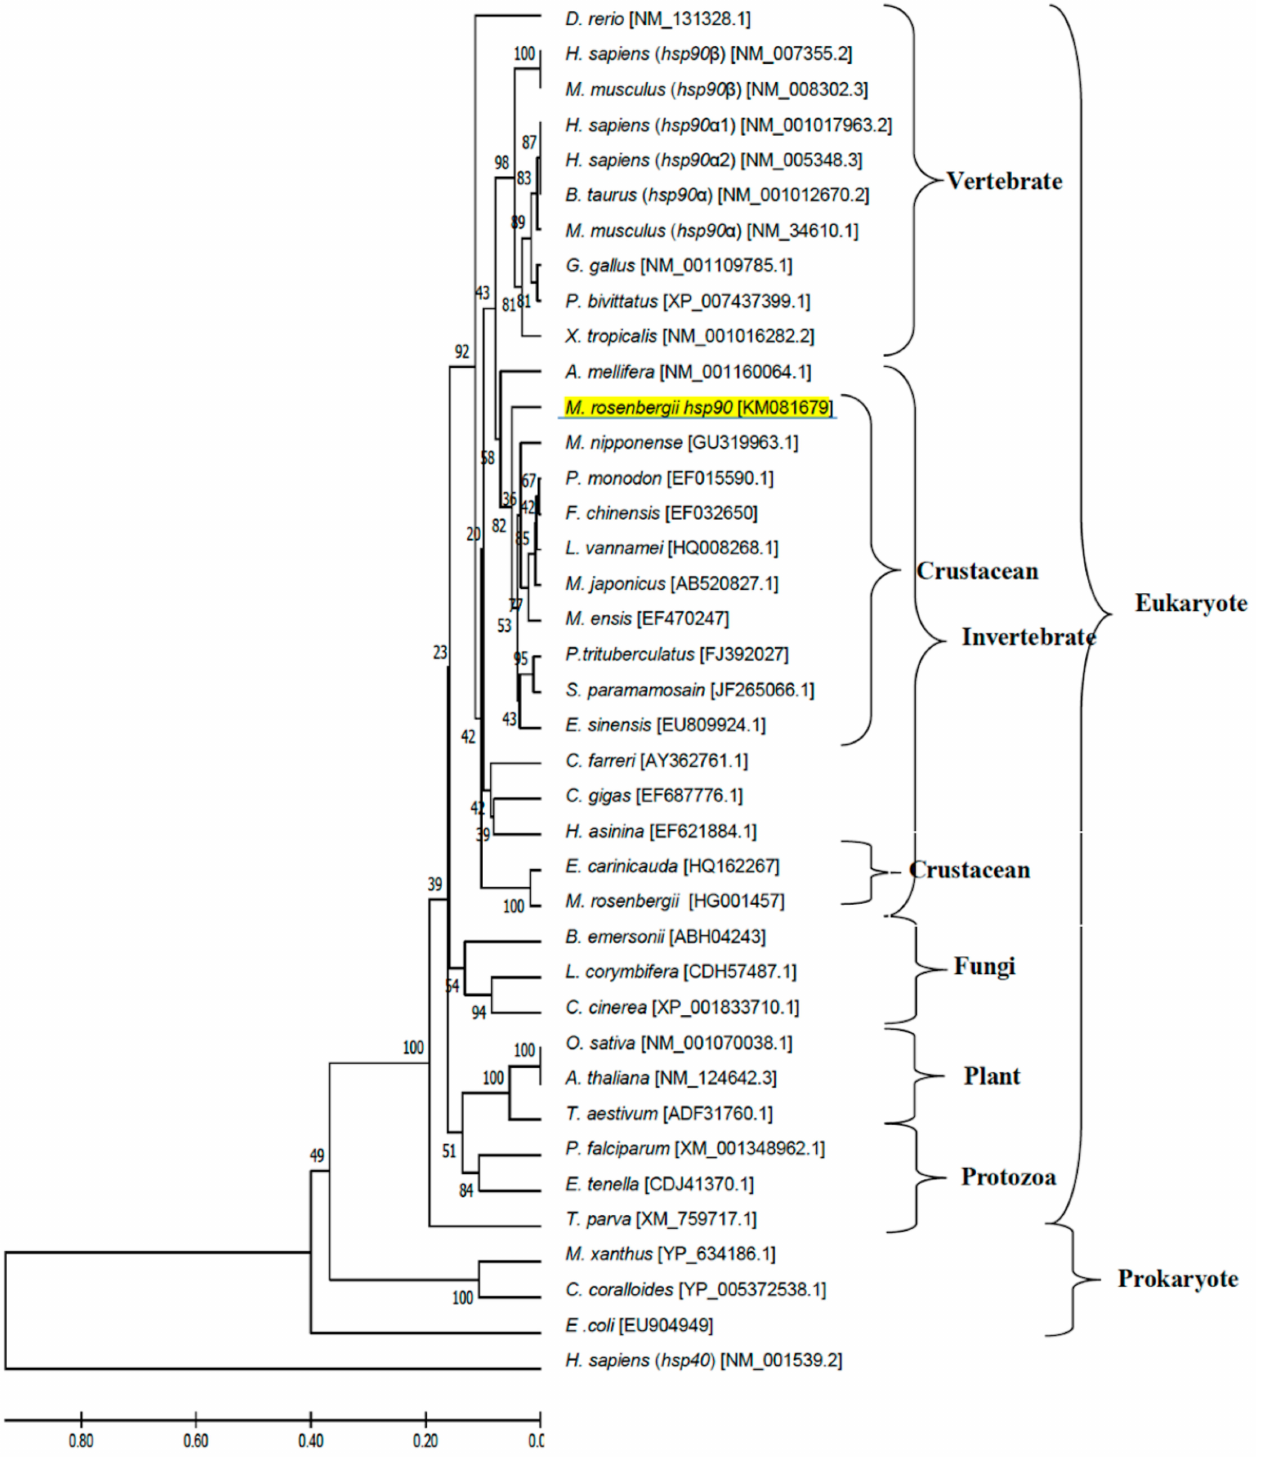
Figure 6. Phylogenetic tree showing the relationship of the Hsp90 gene of the Macrobrachium rosenbergii amino acid sequence with those of other known species produced using the neighbor-joining method. Sequences used in the tree, followed by their GenBank accession number, are shown in Supplementary Material Table S2. Mr-hsp90 is